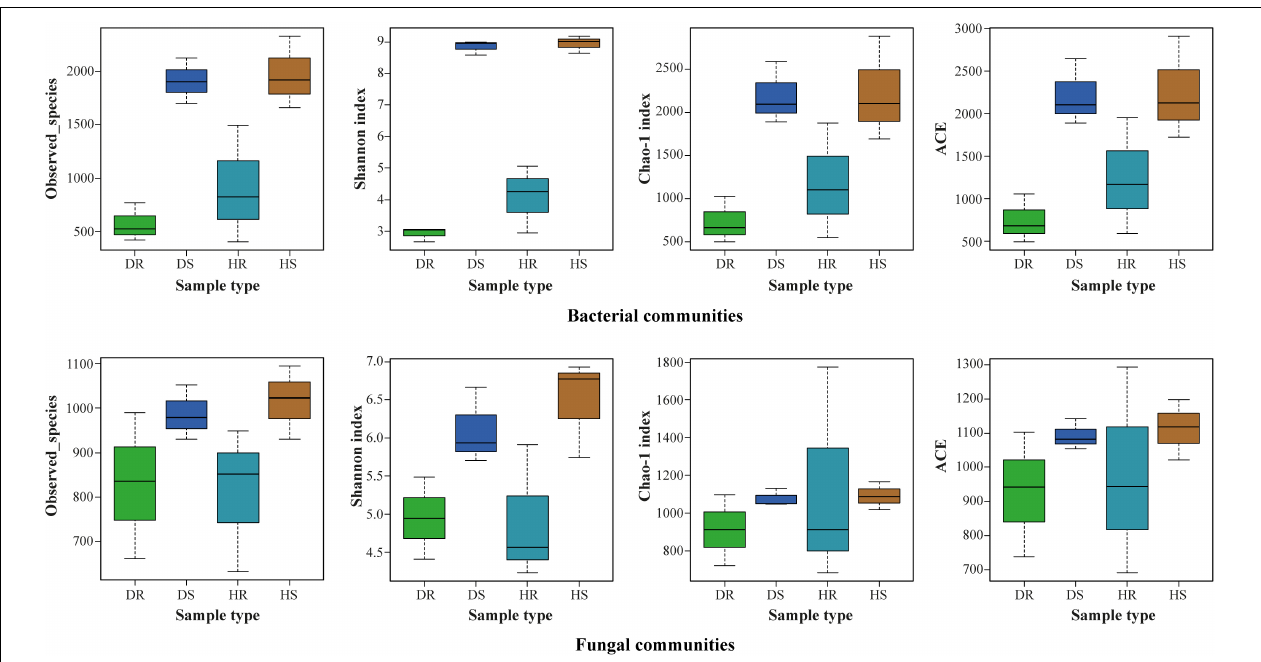
FIGURE 3 | Boxplot of bacterial (top) and fungal (bottom) showing alpha diversity indexes of flue-cured tobacco plants under three variables. HS, healthy rhizosphere soil; DS, diseased rhizosphere soil; HR, healthy roots; DR, diseased roots.